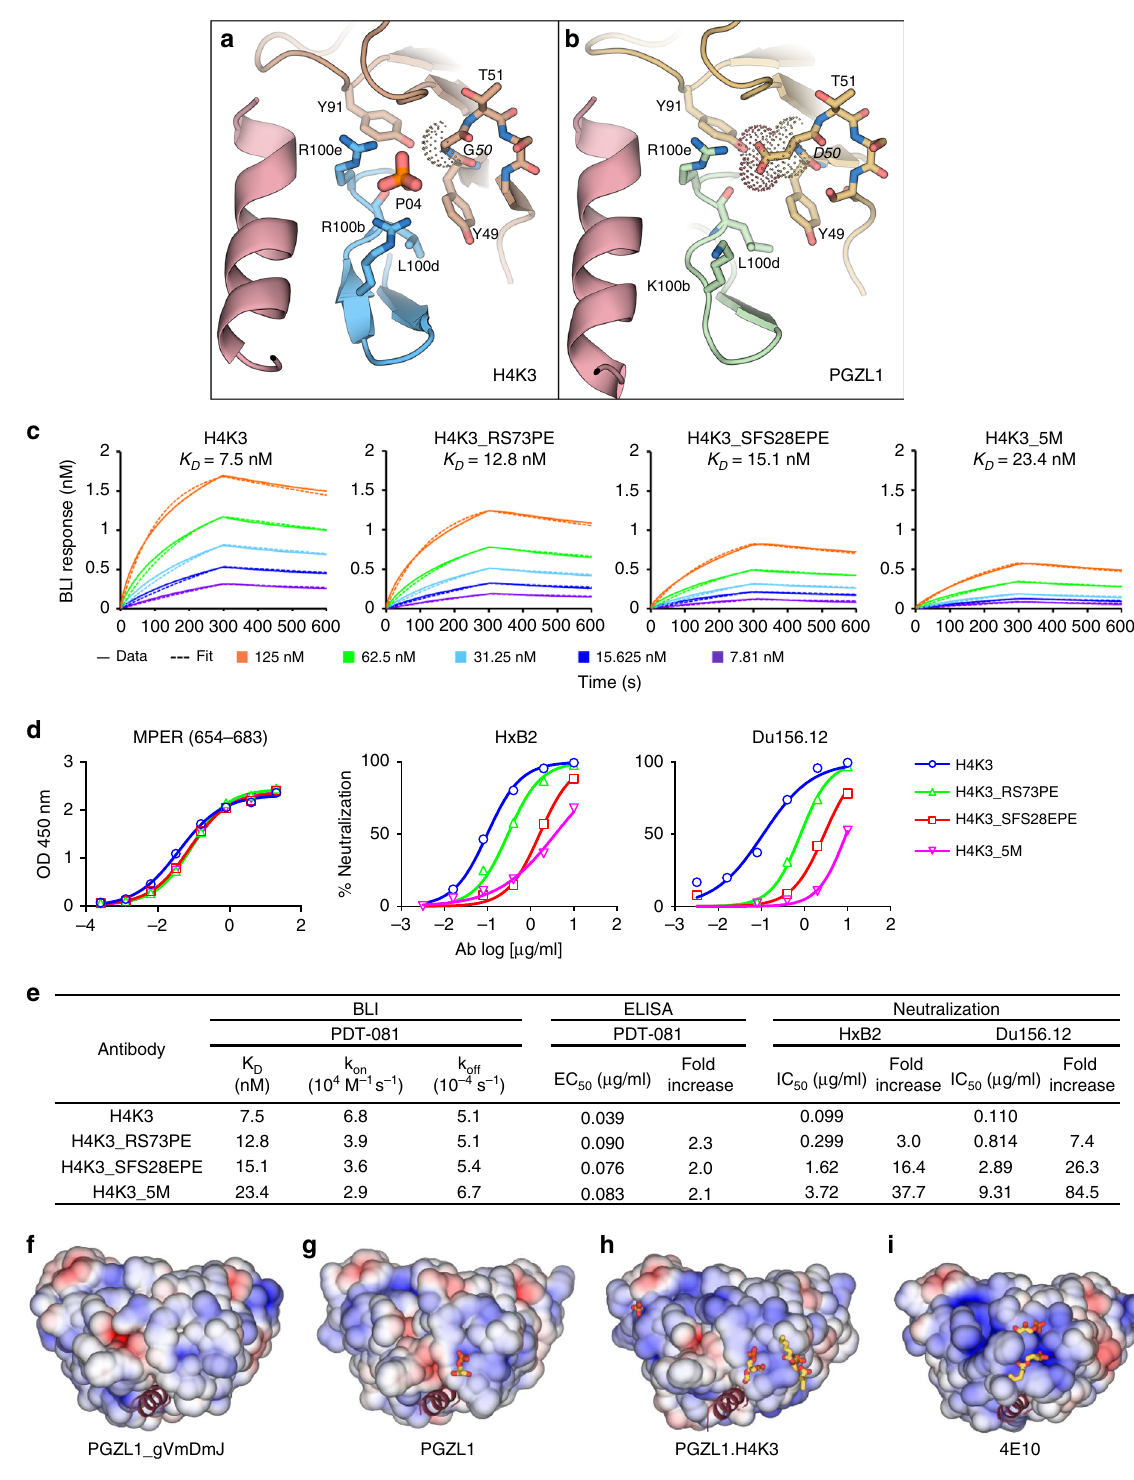
Fig. 6 MPER-induced PO 4 -binding site of H4K3 and PGZL1 lipid site mutant characterization and electrostatics. a , b Stick rendering of the PO 4 -binding site in ( a ) H4K3 and ( b ) PGZL1. The side chain at LC position 50 in each antibody is surrounded by dots. Select HC residues of the two antibodies are shown in blue ( a ) and green ( b ), and the LC is shown in brown. MPER is shown as a pink ribbon. c Binding of H4K3 lipid-binding site mutants to immobilized MPER peptide by BLI. d Binding of H4K3 lipid-binding site mutants to MPER peptide by ELISA and neutralization (log IC 50 ) of HxB2 and Du156.12. e BLI, ELISA binding to MPER peptide, and neutralization statistics. f – i Surface rendering, along the MPER helical axis (red ribbon), of the solvent accessible electrostatic potential contoured at ± 5 kT/e for ( f ) PGZL1 gVmDmJ, ( g ) PGZL1, ( h ) H4K3, and ( i ) 4E10. Observed lipid fragments and anions are shown as sticks. Source data for h and i are provided as a Source Data fi